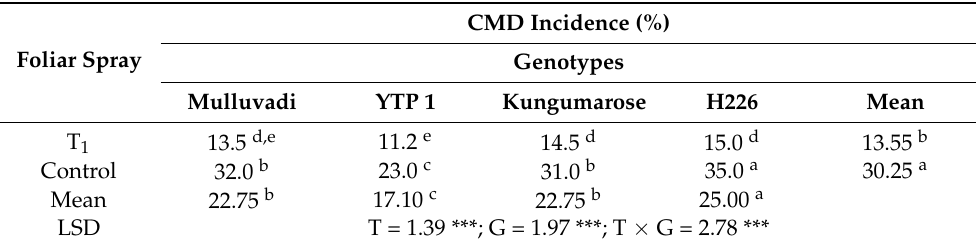
Table 7. Interactive effects of combined nutrient/biocontrol agent mixture foliar spray and genotypes on CMD (%) of cassava. The data presented are the mean of two seasons ( n = 10). Means followed by the same letter are not statistically significant at p < 0.05.